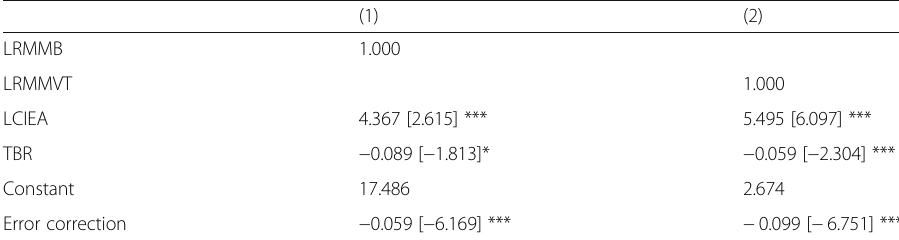
Table 6 The long-run mobile money demand model (1) (2) LRMMB 1.000 LRMMVT 1.000 LCIEA 4.367 [2.615] *** 5.495 [6.097] *** Constant